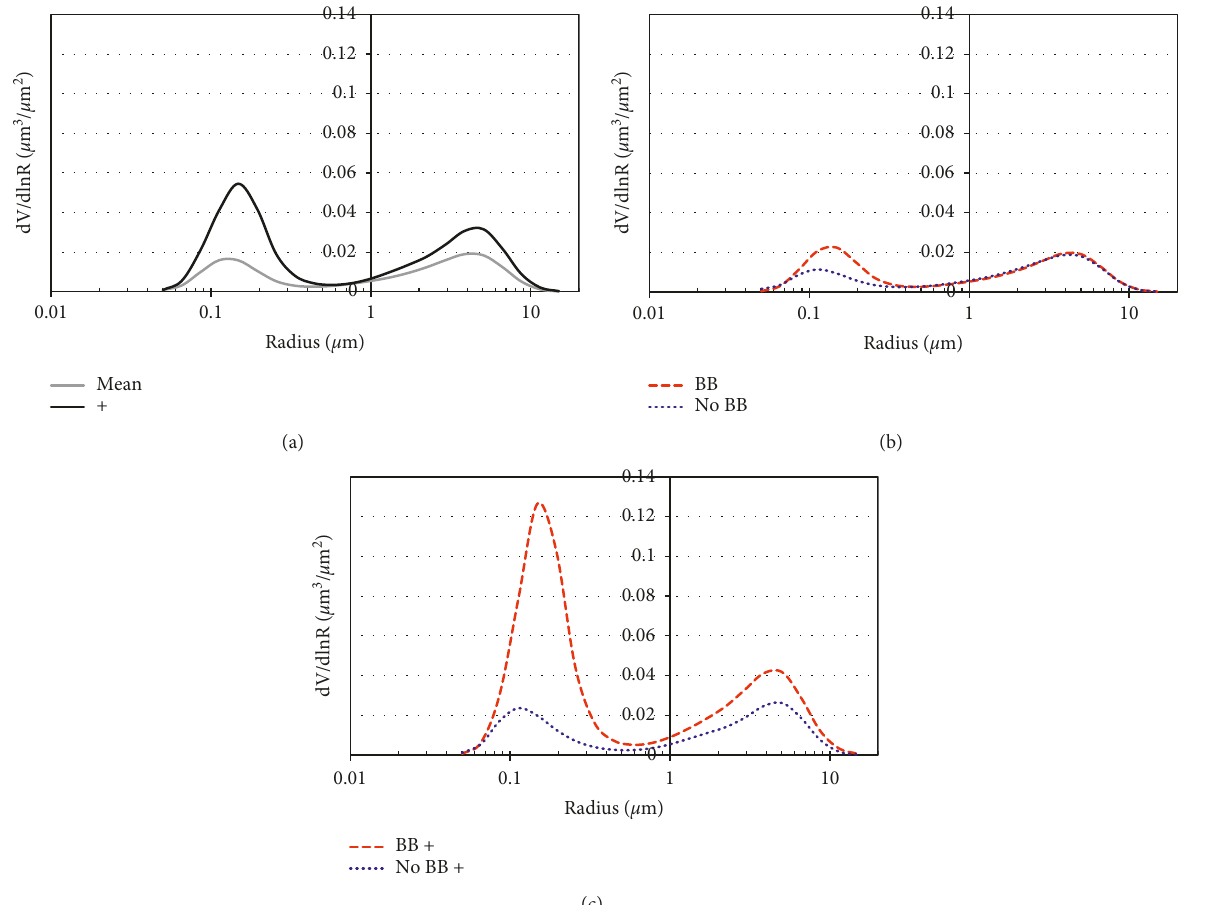
Figure 5: Mean volume size distributions of aerosols at CEILAP-BA. (a) Comparison of size distributions between the entire period and selected days, black line: days with regional transport of biomass-burning aerosols and grey line: all days; (b) comparison of size distributions for all days during the biomass-burning months (red line) and no-burning months (blue line); (c) comparison of size distributions for the selected dates during biomass-burning months (red line) and no-burning months (blue line). + denotes the “selected